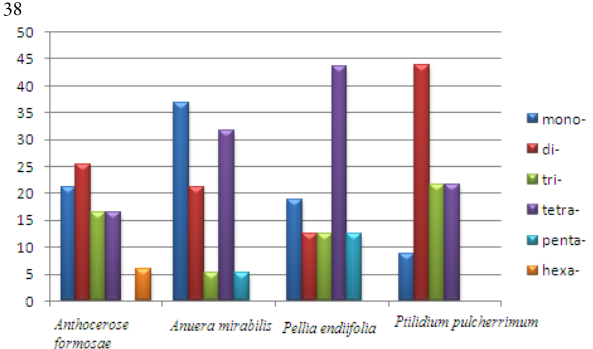
Fig. 1. The frequency of each SSR repeats (mono- to hexa) in four bryophytes species (Shanker 2013a, 2013b, 2014a,